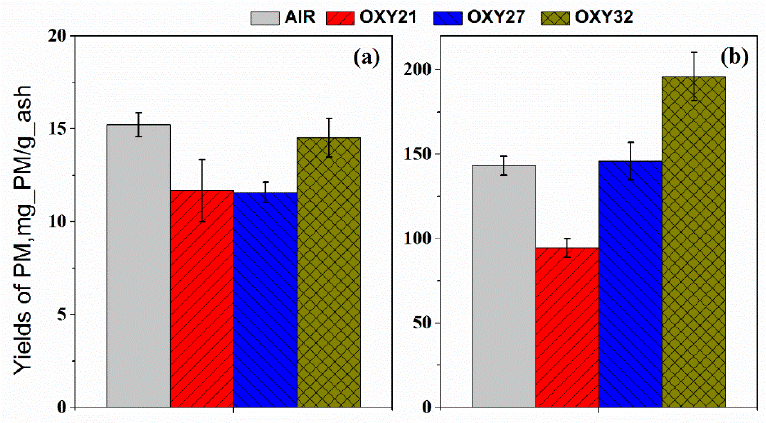
Figure 5. Mass yields of PM 10 formed during the air and oxy-fuel combustion of Zhundong coal. ( a ) PM 0.5 ; ( b ) PM 0.5–10 .